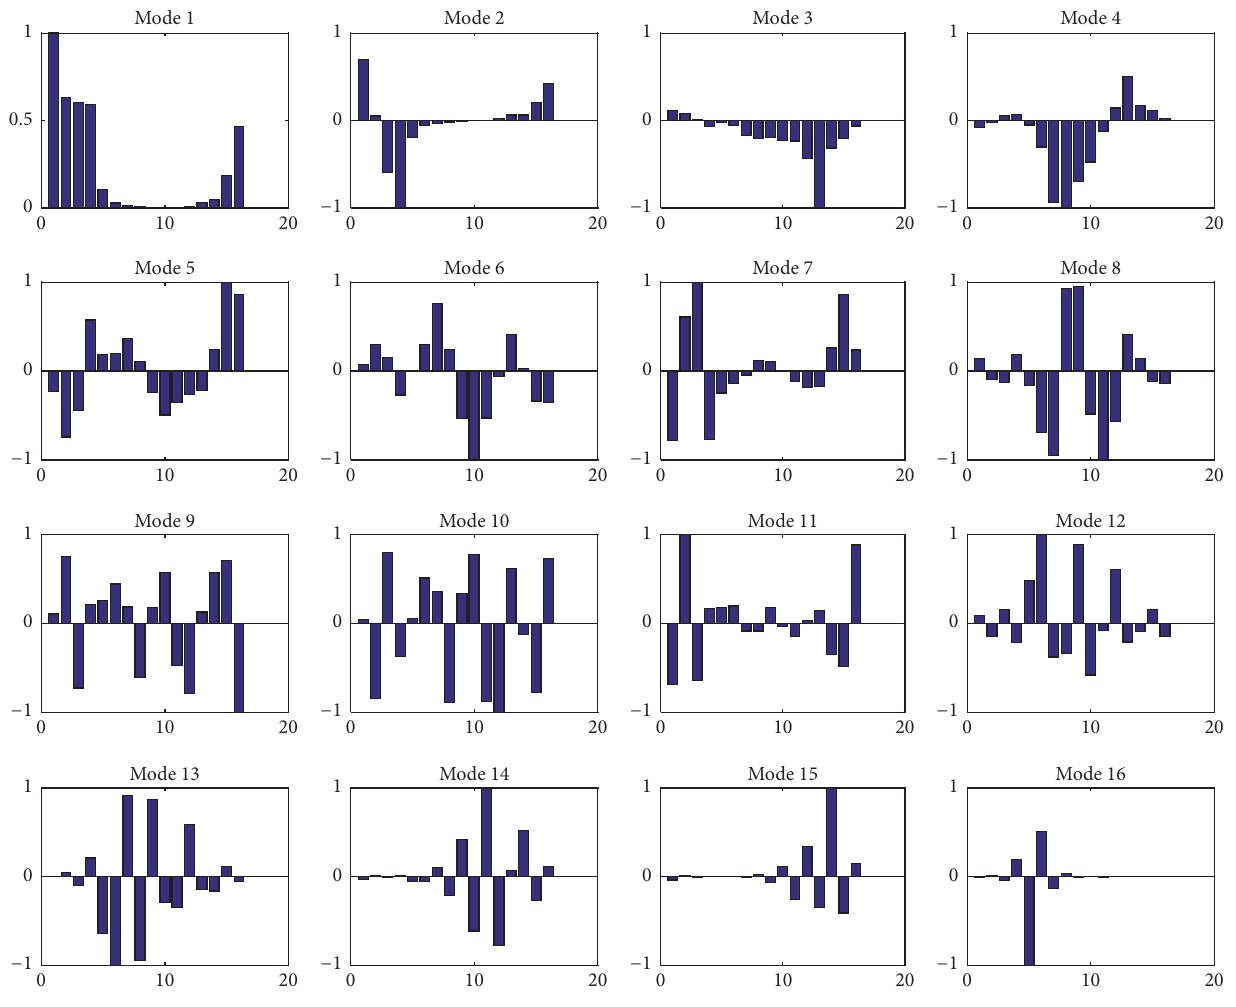
Figure 5: Natural shapes of MRBs under different orders.